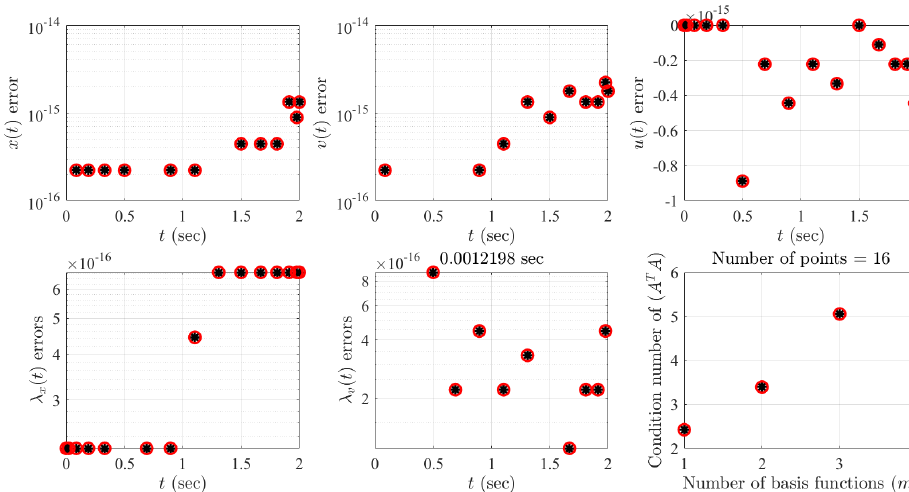
Figure 1. Results of the 4 × 4 optimal control